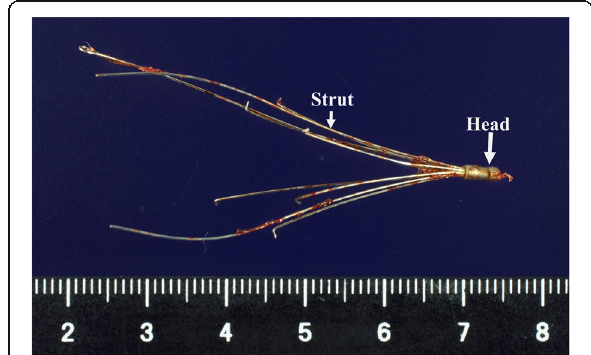
Fig. 6 Retrieved IVC filter. The long arrow indicates the head of the IVC filter. The short arrow indicates the strut of the IVC